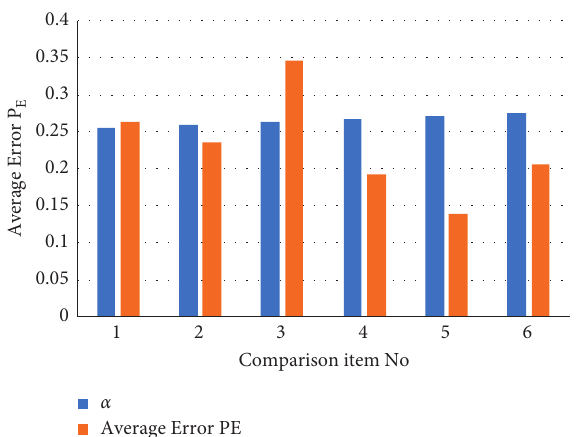
Figure 7: The influence of different values of parameters on the security of the algorithm.